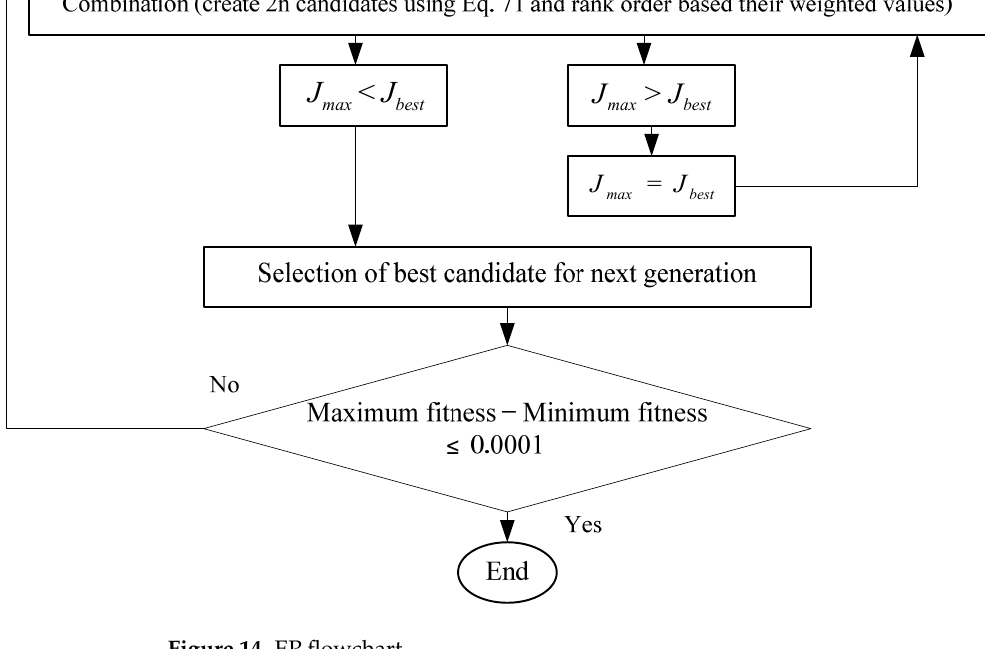
Figure 14. EP Figure 14. EP flowchart.